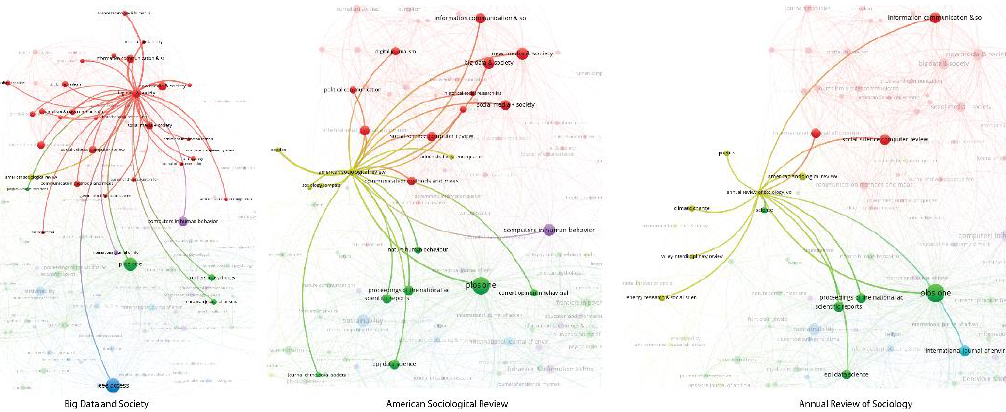
Figure 8. Focus view of Big Data & Society, Annual Review of Sociology and American Sociological Review in the Citation impact environment of CSS, based on WoS, Citing CSS dataset.